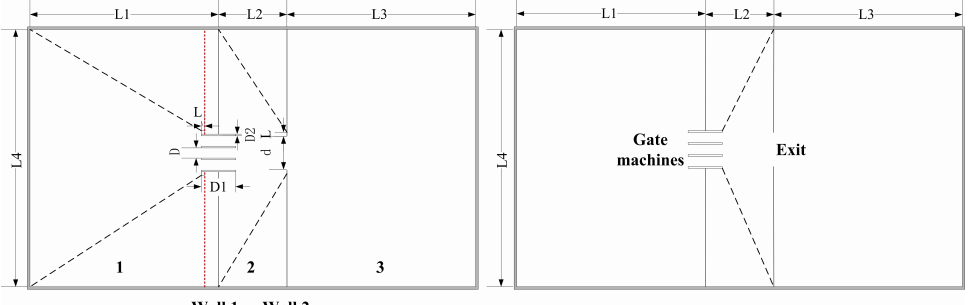
Figure 3. The simulation scenario. L = 0.2 m. ( Left ): The situation where pedestrians exit the gates. ( Right ): The situation where pedestrians come in from the gates.